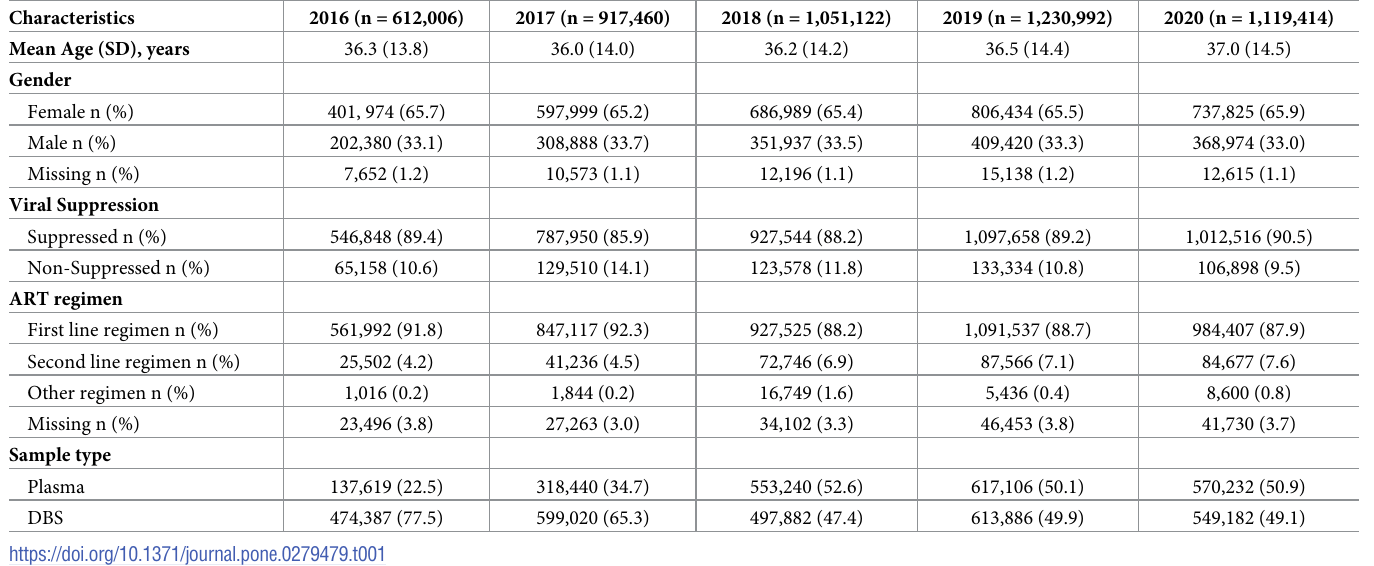
Table 1. Characteristics for the program data for the individual years from 2016 to 2020.